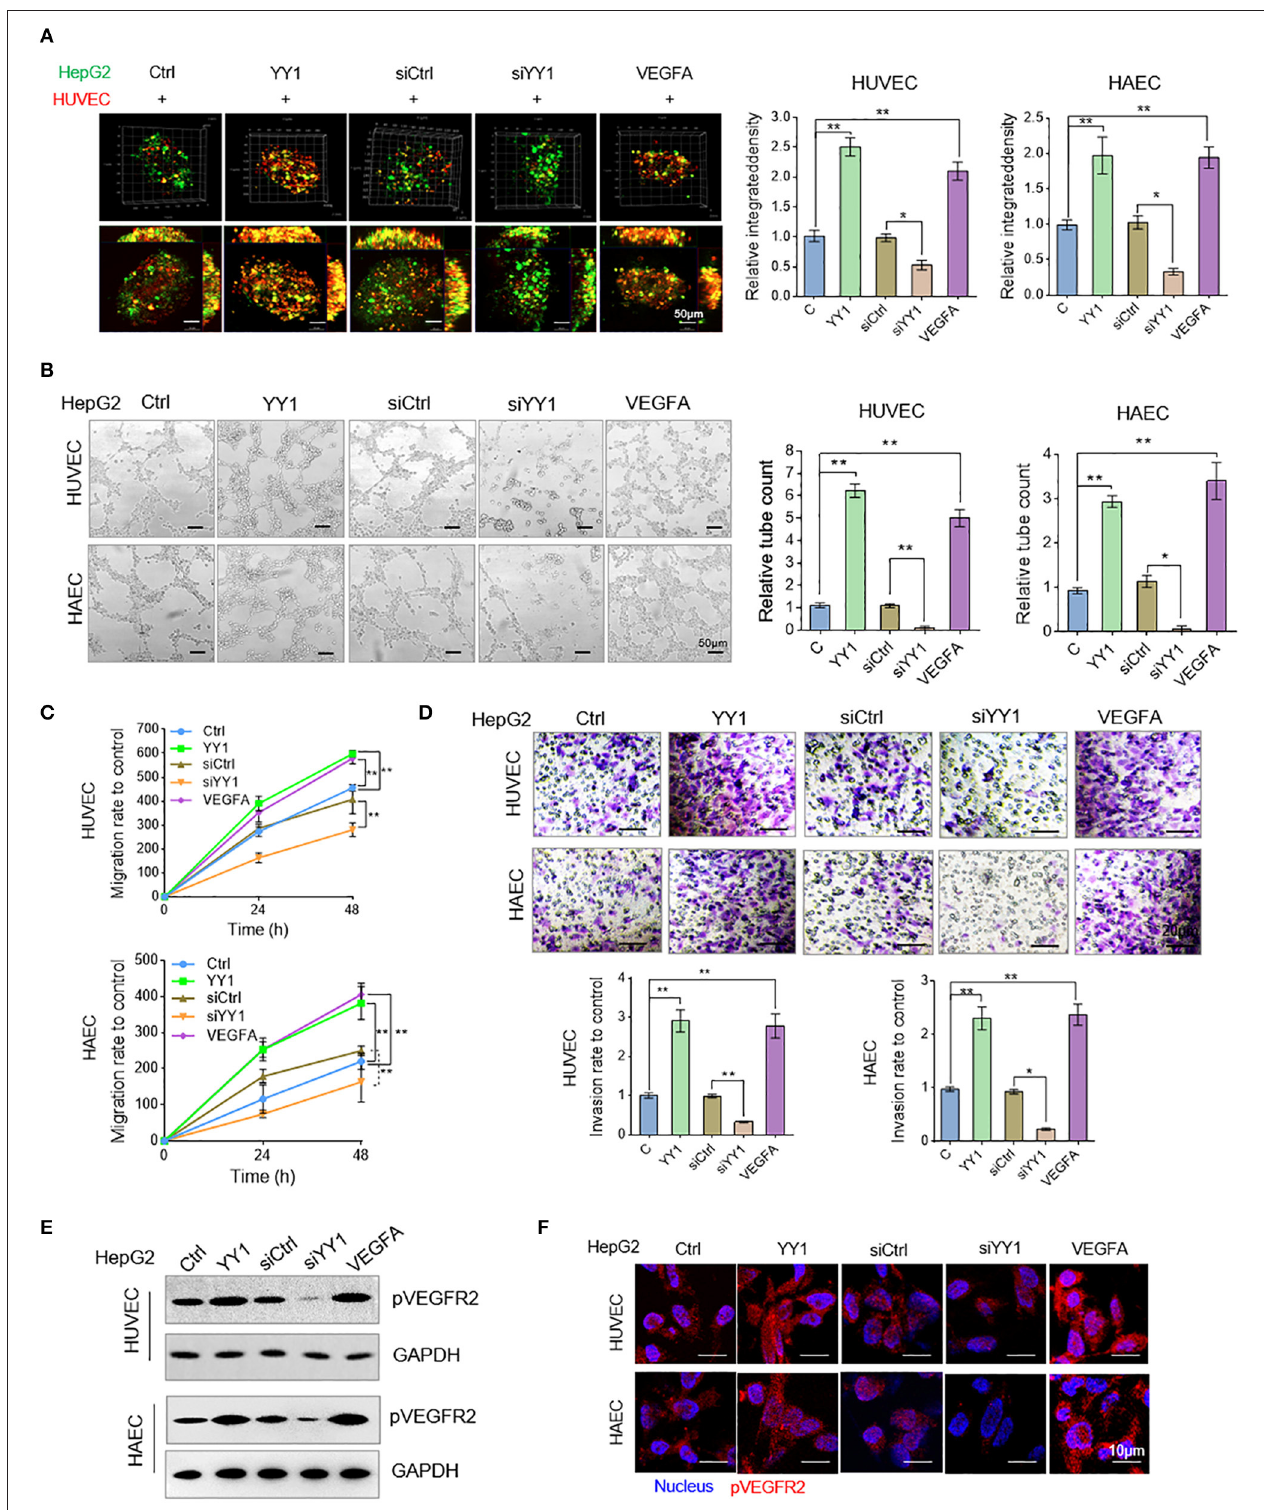
FIGURE 4 | YY1 stimulated HCC cell culture media accelerated endothelial cells neovascularization. (A) HUVECs and HAECs (red) and HepG2 cells (green) co-cultured in a 1:2 ratio and formed three-dimensional spheroids. Images were taken with a laser scanning confocal microscope, scale bar = 50 µ m. (B) Representative image (left) of the formation of HUVECs and HAECs tubes following an incubation with supernatants collected from the indicated cells. Tube formation quantification were analyzed (right). Scale bar = 50 µ m. (C) HUVECs and HAECs migration were detected after an incubation with supernatants collected from the